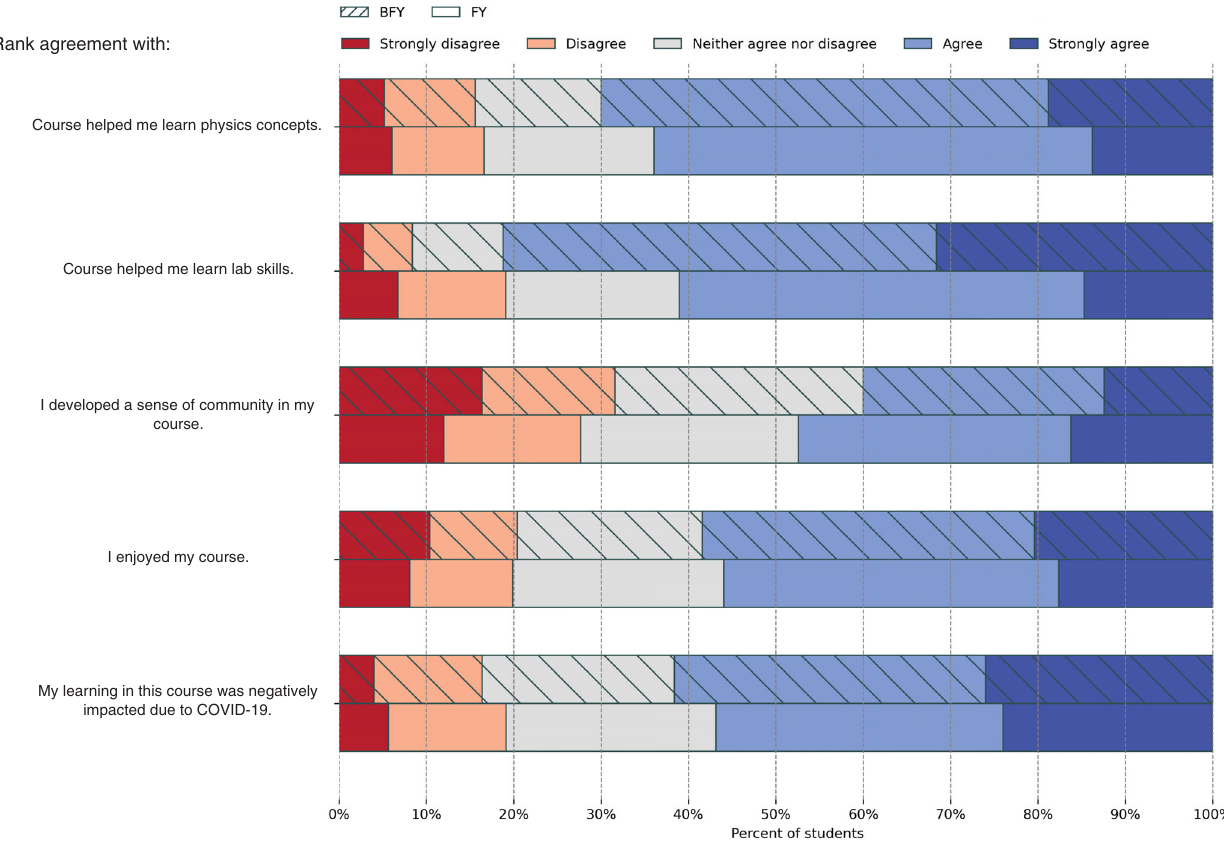
FIG. 5. Percent of students in FY (plain, N ¼ 4565 ) and BFY (hatched, N ¼ 250 ) courses who strongly disagree (dark red) through strongly agree (dark blue) that they attained various course